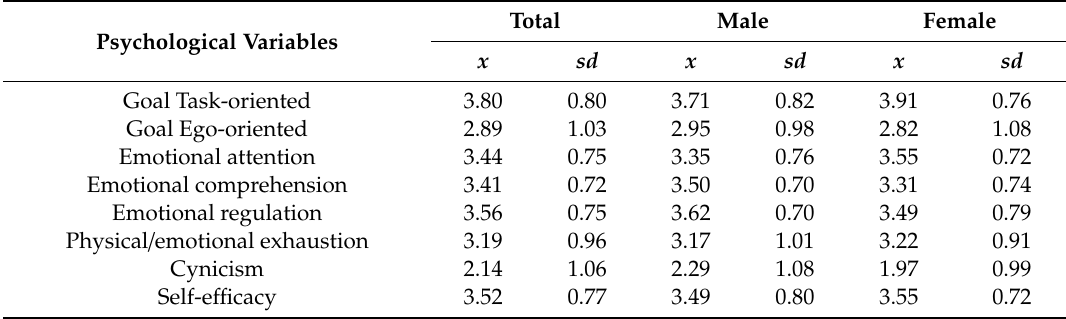
Table 2. Goal orientation, emotional intelligence, and academic burnout descriptive variables. Psychological